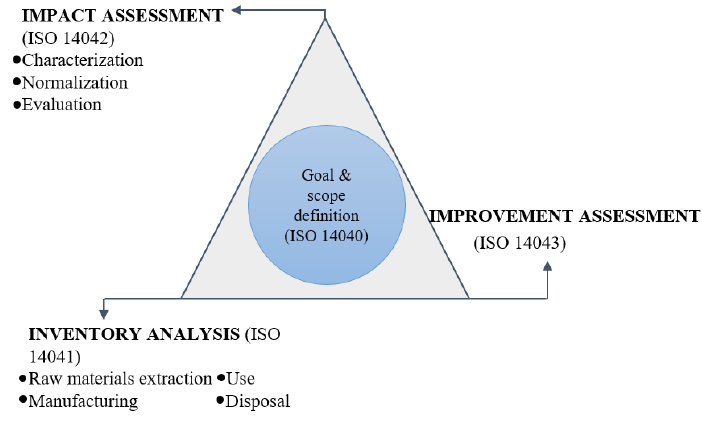
Figure 1. Structure of LCA study. 112